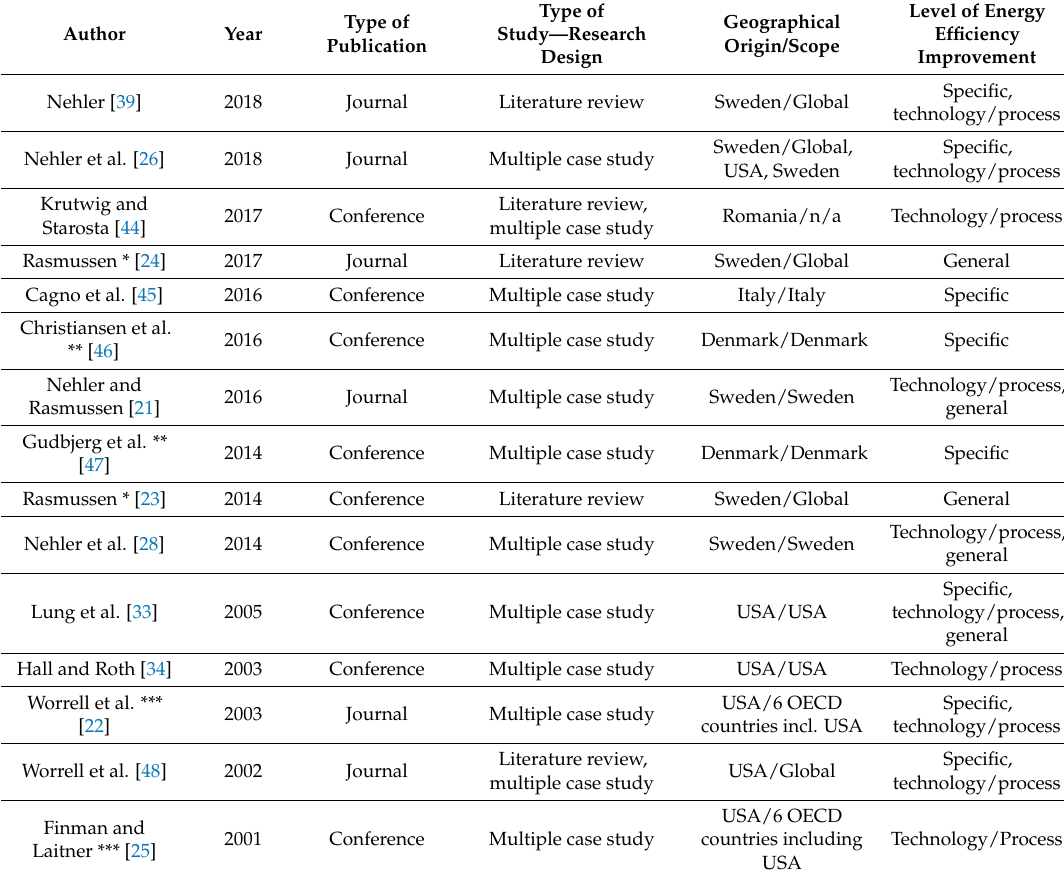
Table 1. Descriptive analysis of the relevant publications for the review in the area of non-energy benefits in industry. USA—United States of America; OECD—Organisation for Economic Co-operation and